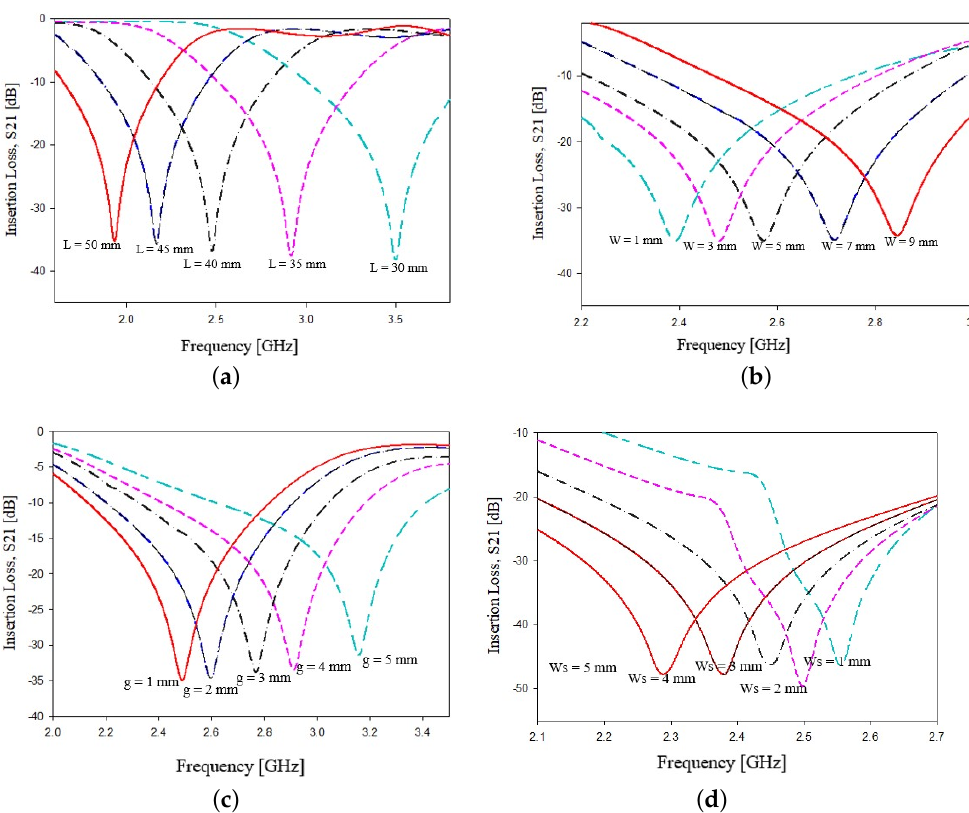
Figure 4. Dependence of the main frequency peak versus variations of geometrical parameters: ( a ) length of the main square loop side L , ( b ) thickness of the square loop microstrip W , ( c ) gap between the two stubs g , ( d ) thickness of the stubs microstrip W s .